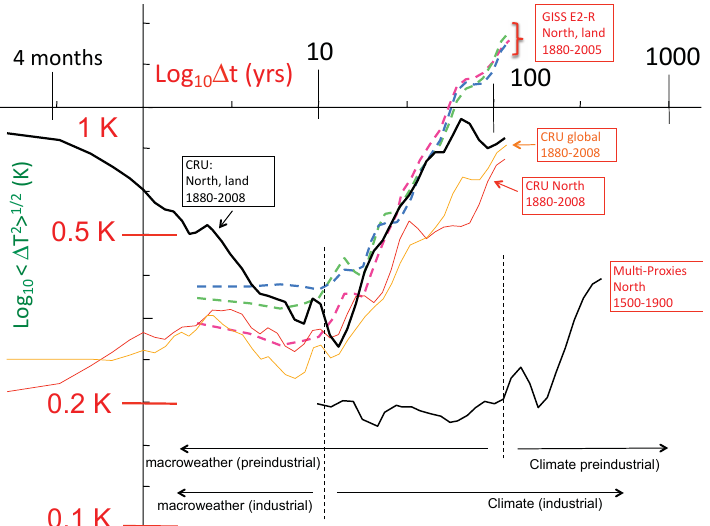
Fig. 5. Recent period instrumental and GCM RMS fluctuations. Comparison of instrumental (CRU, HadCRUT3, black, thick, Northern Hemisphere land only) and GISS-E2-R (dashed: Crowley and Gao volcanic reconstructions (green and blue respectively) and solar only (red); all are for the Northern Hemisphere land only). Gao and Crowley refer to the Gao et al. (2008) and Crowley et al. (2008) volcanic reconstructions discussed in the text. Also shown for reference are the CRU global (orange) and Northern Hemisphere (land and ocean, red) S(1t) for the period 1880–2008. Also shown for reference is the preindustrial multiproxy series (from Fig. 3). Notice that the weather– macroweather transition scale (where the slopes change sign) is roughly 10yr in the industrial epoch, but closer to 100yr in the preindustrial epoch (bottom